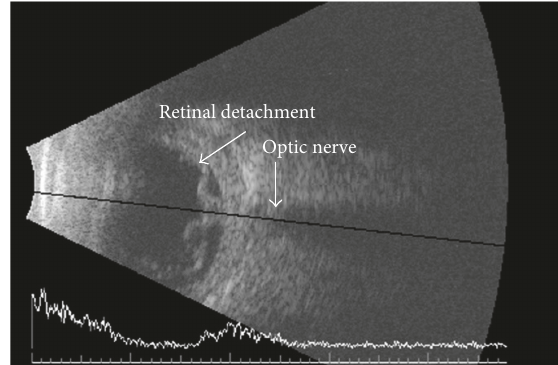
Figure 1: OS B-scan 10 days after final vitrectomy demonstrating funnel retinal detachment tethered to optic nerve